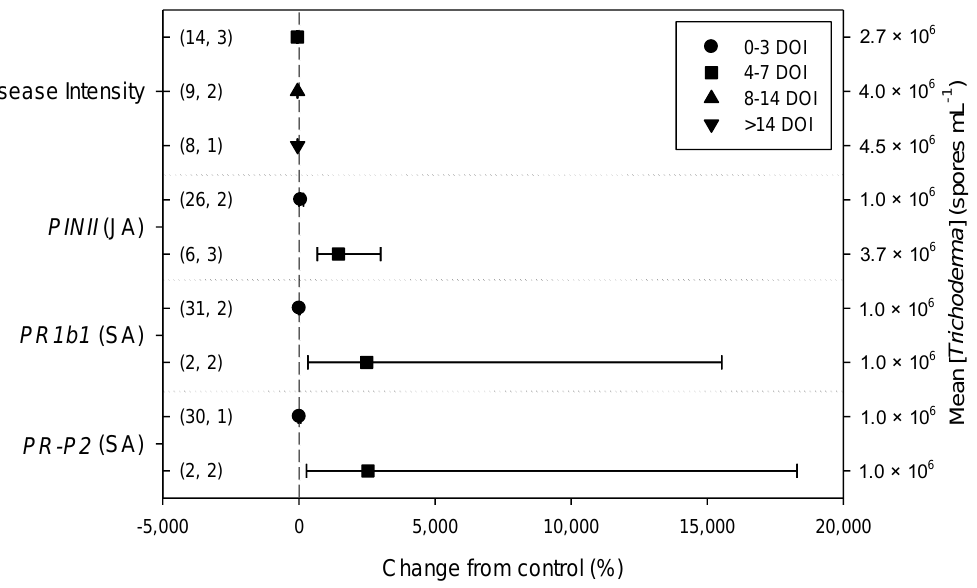
Figure 5. Differential effects of Trichoderma on Botrytis cinerea infection (i.e., disease intensity) and defense-related genes involved in jasmonic (JA; i.e., proteinase inhibitors II, PINII ) and salicylic acid (SA; pathogenesis-related 1b1 and P2, PR1b1 and PR-P2 ) pathways in tomato leaves on the basis of duration of B. cinerea infection (0 – 3, 4 – 7, 8 – 14 and >14 days of infection, DOI). Symbols represent the mean percentage change due to Trichoderma treatment relative to control (i.e., B. cinerea infection without Trichoderma treatment), and the bars show the 95% confidence interval. Number of observations and papers are shown in parentheses; mean Trichoderma spp. concentrations are given along the right y axis.